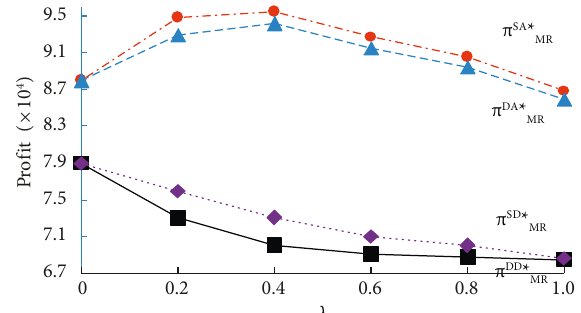
Figure 9: The effect of λ on w and p .